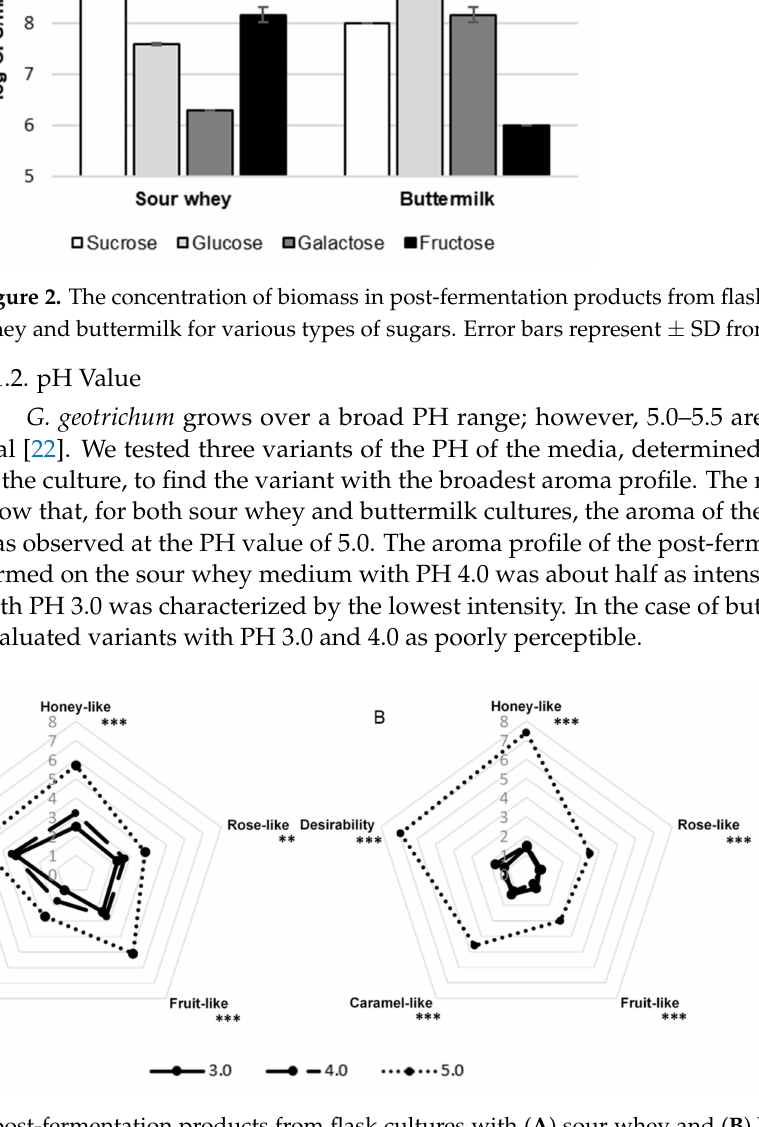
Figure 3. Sensory profiles of post-fermentation products from flask cultures with ( A ) sour whey and ( B ) buttermilk for various types of PH of the media. ** p < 0.01; *** p <